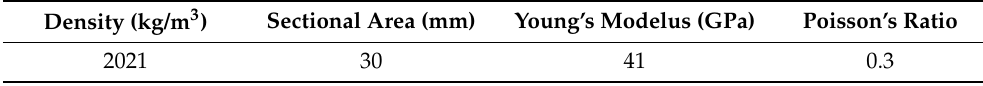
Table 4. Physical parameters of interphase spacers.